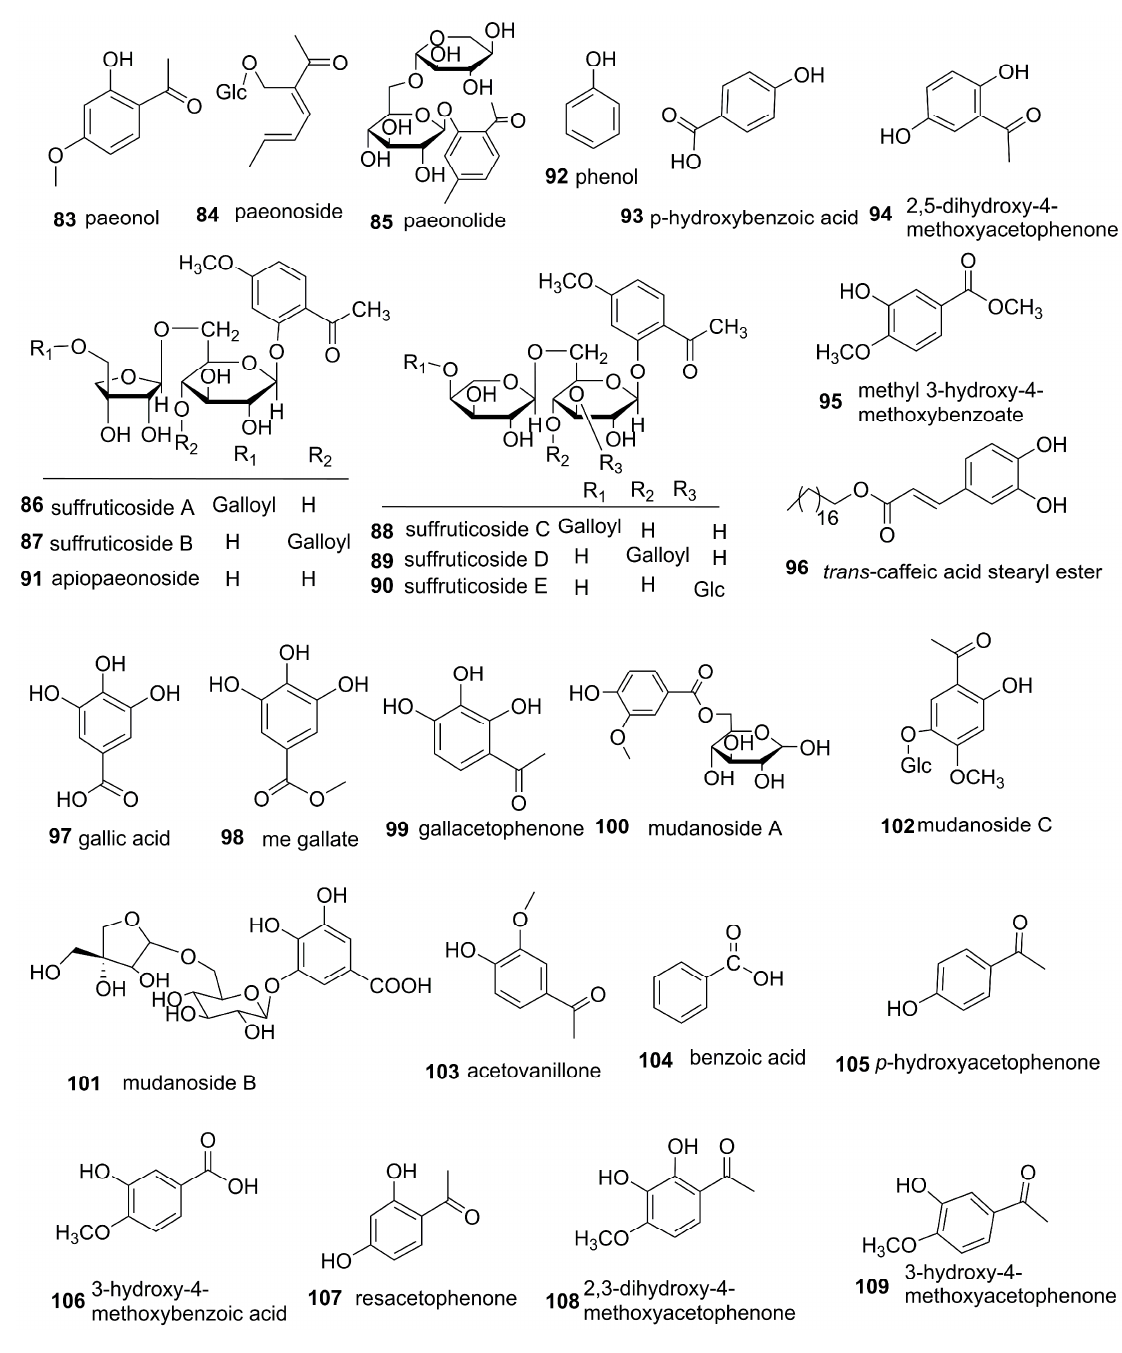
Figure 2. Cont . Figure 2.